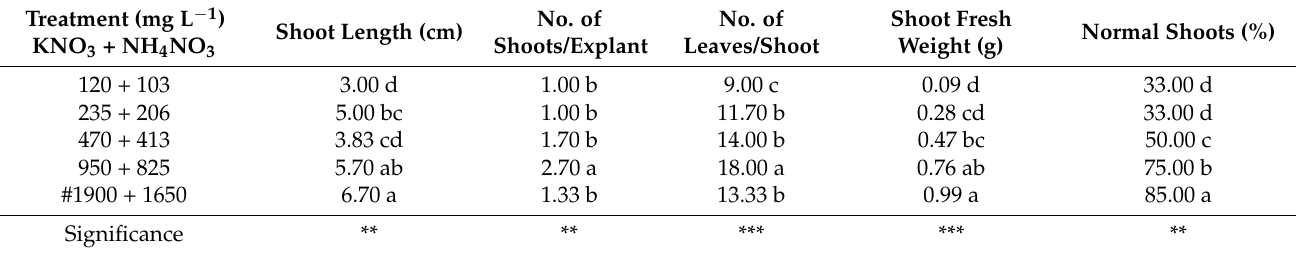
Table 2. Effect of potassium nitrate (KNO 3 ) and ammonium nitrate (NH 4 NO 3 ) on growth and hyperhydricity reversion of G. paniculata in vitro shoots after four weeks of in vitro culture. All